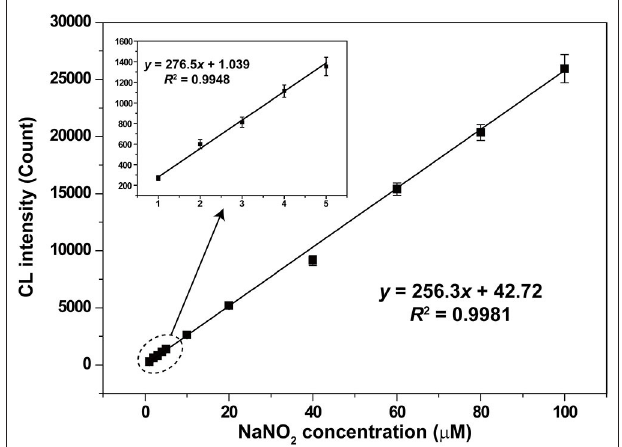
FIGURE 7 | Calibration curve for nitrite analysis based on the LaF 3 :Ce NPs-enhanced CL. The standard error bars mean the variation of three